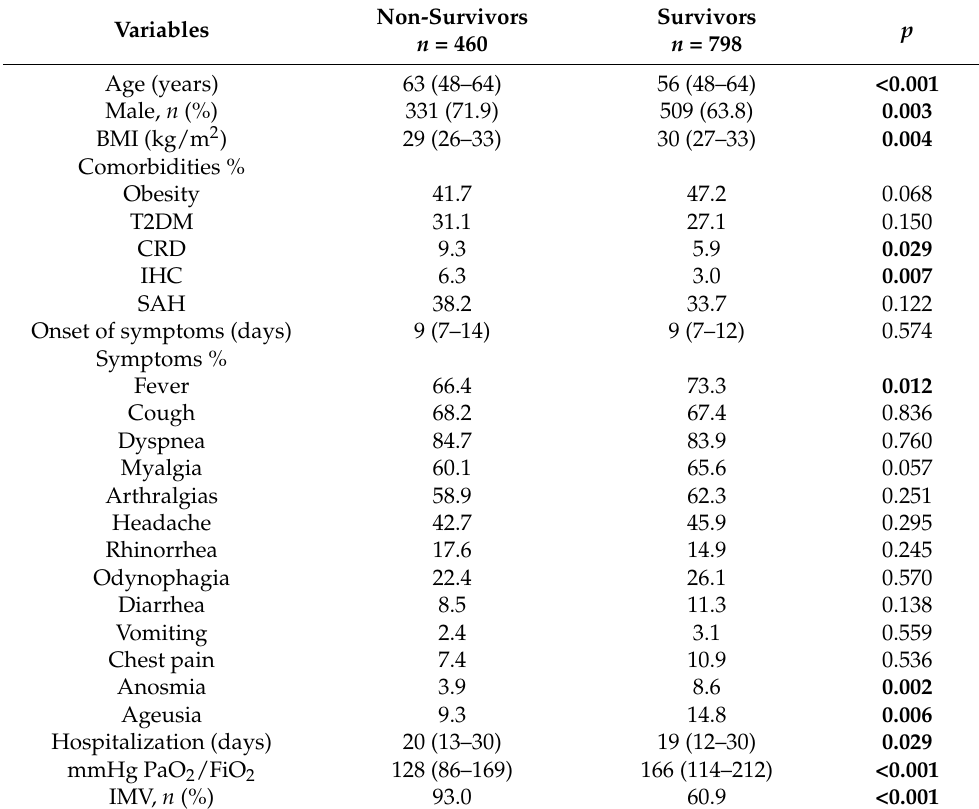
Table 1. Demographic and clinical characteristics of the COVID-19 patients included in this study.